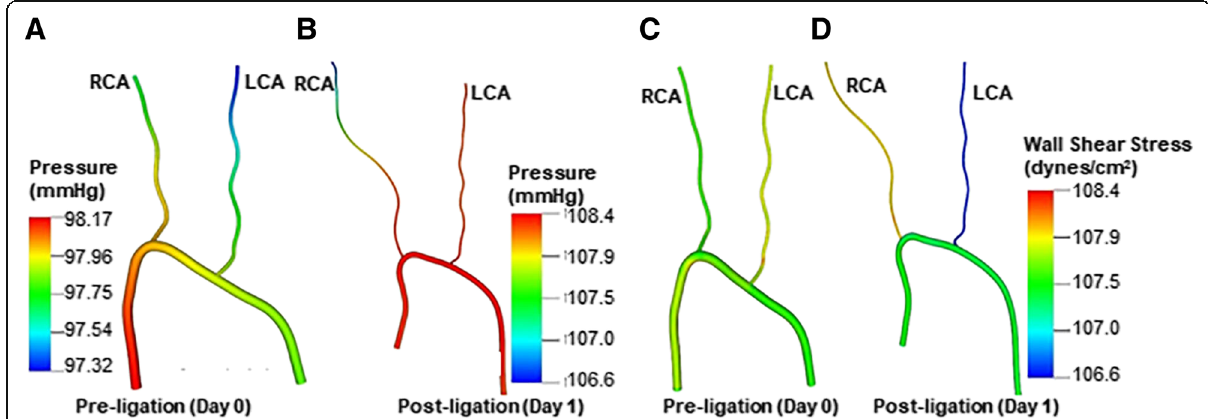
Fig. 2 Pressure contour plots and wall shear stress from pre- and post-ligation mice. a Representative pressure contour plot of a pre-ligated mouse. b Representative pressure contour plot of a post-ligated mouse. c Representative wall shear stress contour plot from a pre-ligated mouse. d Representative wall shear stress contour plot from a post-ligated